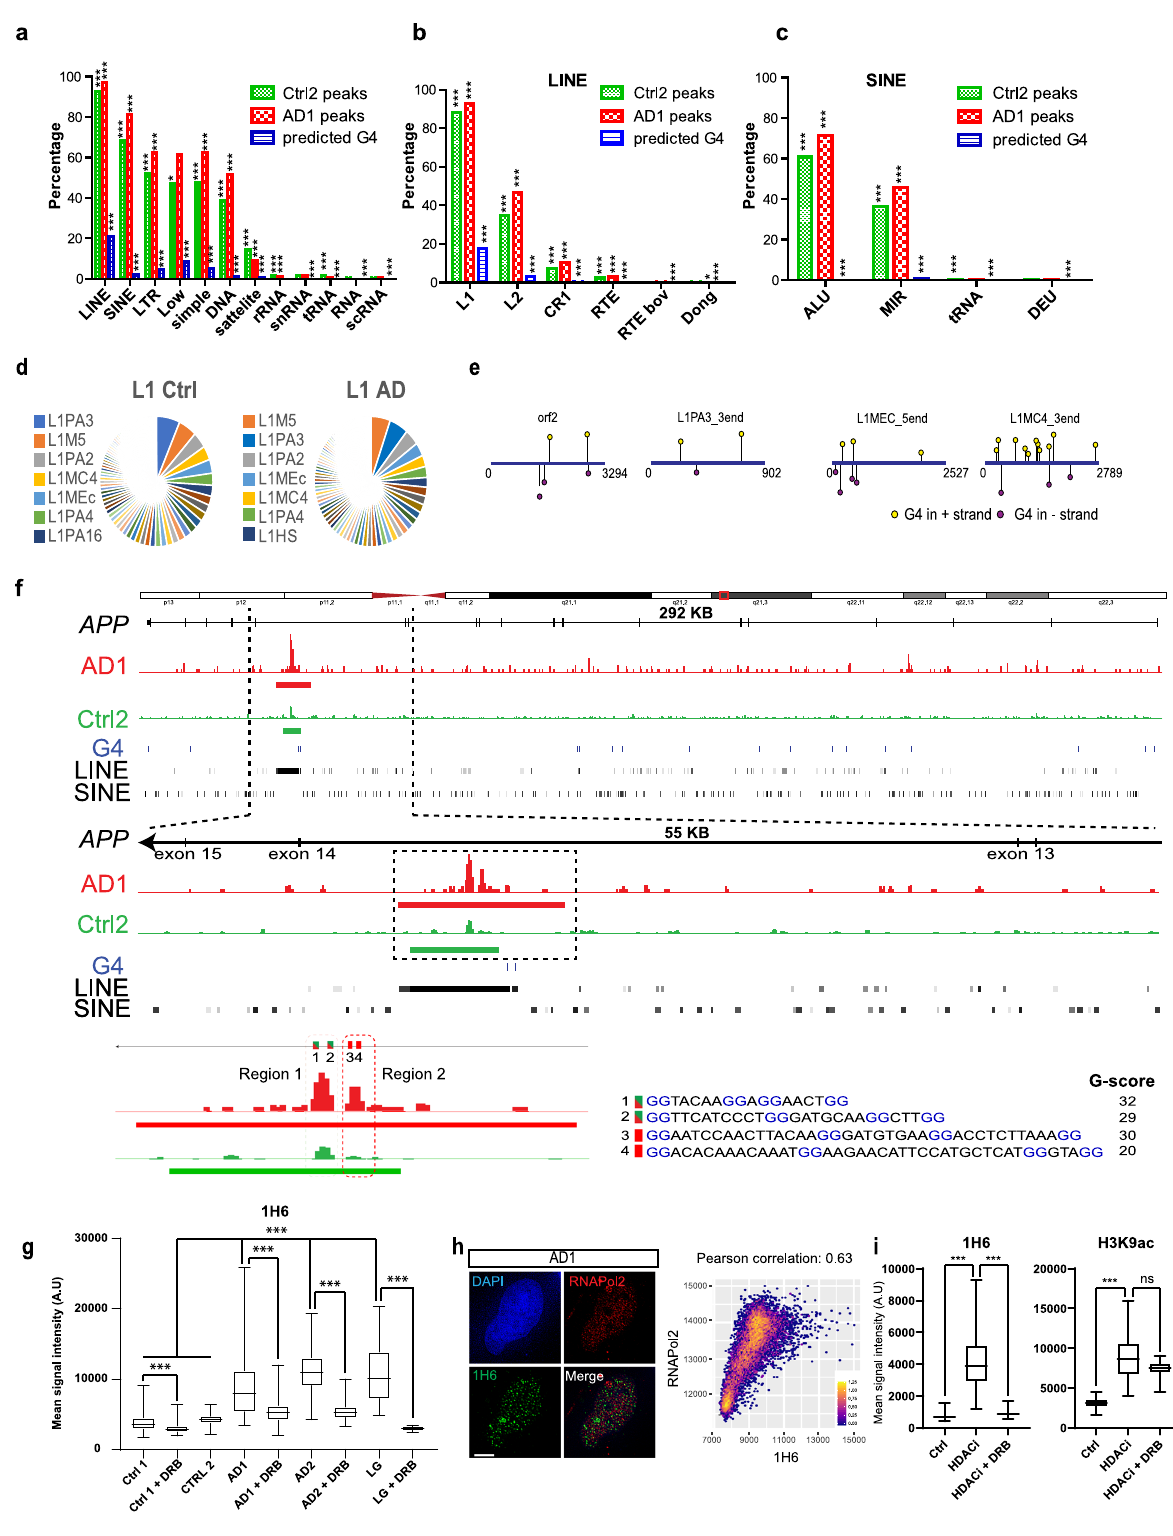
synaptogenesis (Fig. 5a). Notably, comparative RNA-seq analysis of Ctrl1 and Ctrl2 neurons with AD1 and AD2 neurons revealed that a subset of genes with intergenic or intragenic peaks pre- sented modi fi ed splicing events (Fig. 5b, c and Supplementary Fig. 11a, b). In the fi rst scenario (lost in AD), a single intergenic peak between SMN1 and NAIP was lost in AD neurons. This resulted in cryptic slicing and/or transcription from SMN1 over